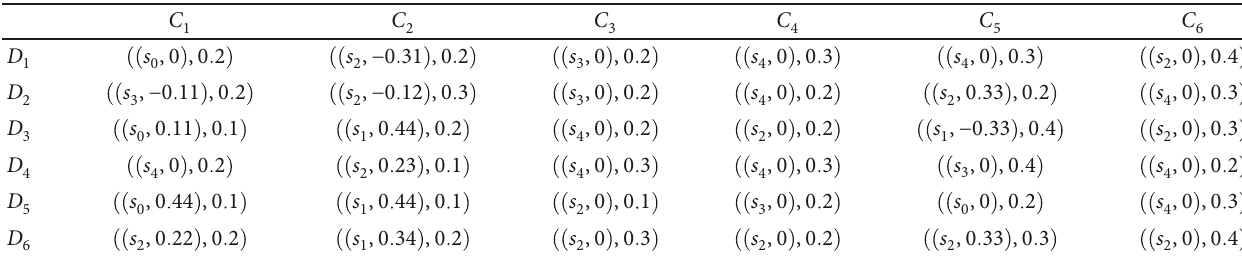
Table 3: Grey linguistic 2-tuple decision matrix Z 3 .